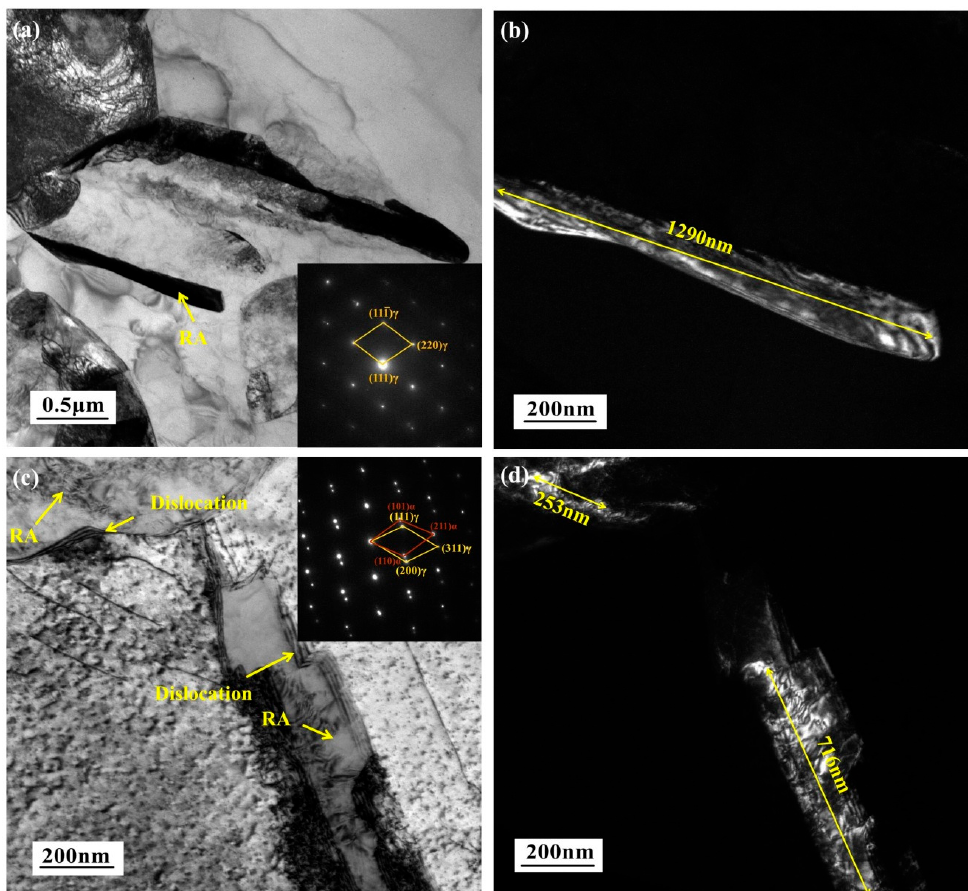
Figure 10. The TEM micrographs of the sample partitioning at 370°C: ( a , c ) bright-field images and ( b , d ) dark-field images.